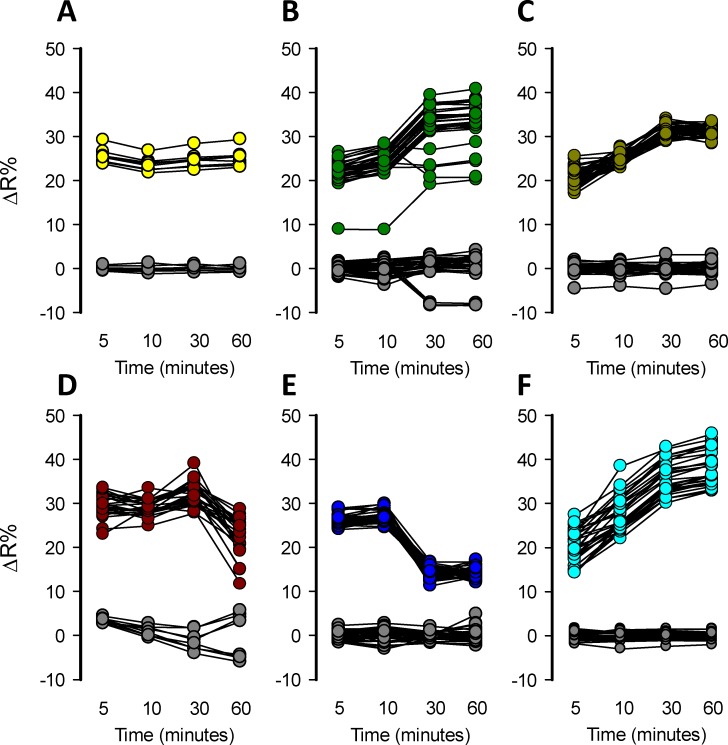
Enhancement of lactate accumulation by transport-stop protocol.All the experiments were performed adding 50 μM of pCMBS together with the mitochondrial toxicant. Measurements were performed at 5, 10, 30, and 60 minutes. A) pCMBS control, B) 32 μM rotenone, C) 16 μM antimycin, D) 5 mM azide, E) 80 μM oligomycin and F) 10 μM myxothiazol. Solvent control (gray circles): KRH buffer for azide, 0.8% DMSO for rotenone, oligomycin, and myxothiazol and 0.16% ethanol for antimycin. All the experiments were performed at 37°C.